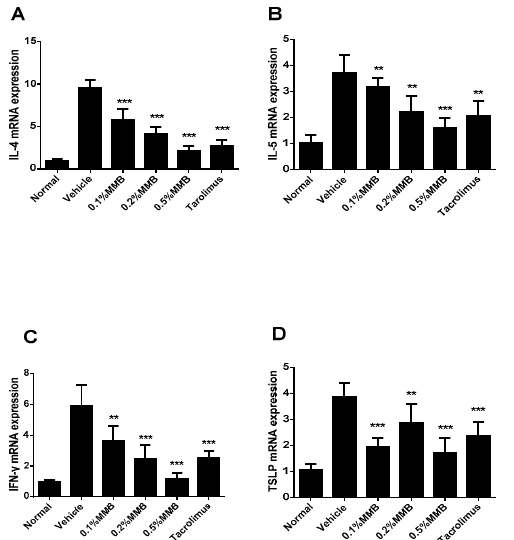
Figure 4. The relative mRNA expression of IL-4 ( A ), IL-5 ( B ), IFN- γ ( C ), and TSLP ( D ) in different groups. Values are mean ± SD ( n = 6). ** p < 0.01, *** p < 0.001 versus the vehicle group.